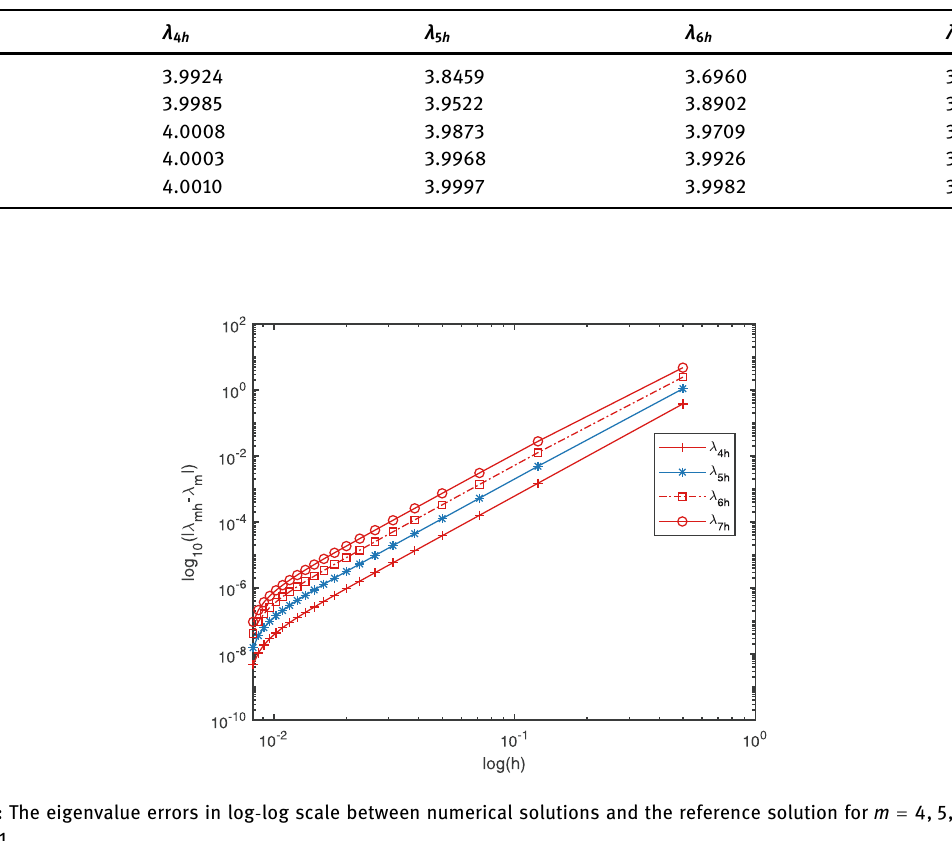
Table 4: Convergence order ( ) c h for the eigenvalues with